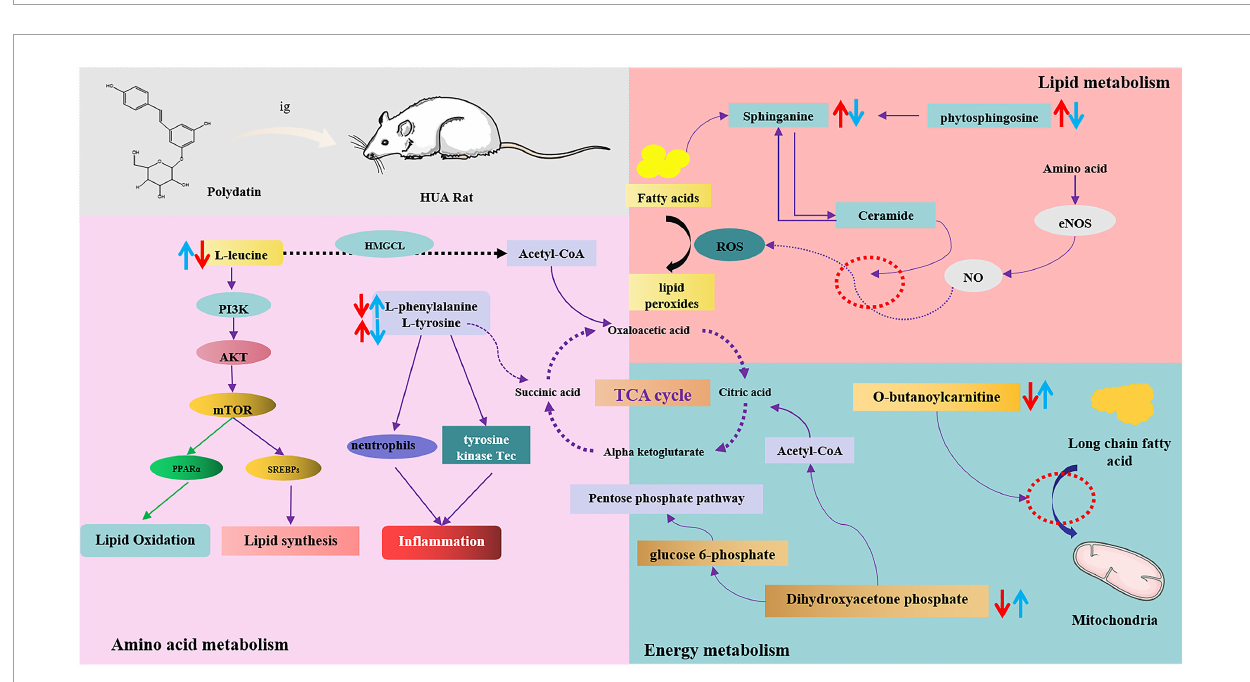
FIGURE7 The intervention metabolisms of polydatin on HUA rats. The red arrow represents the changes of metabolites in hyperuricemic rats, and the blue arrow represents the changes of metabolites after oral administration of polydatin.